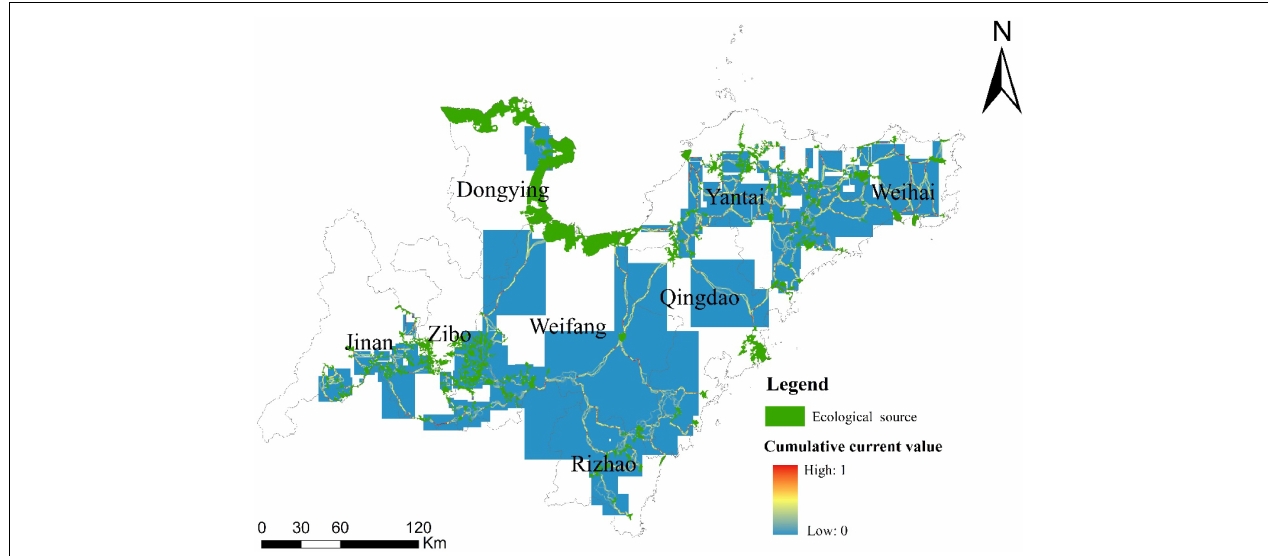
FIGURE 8 | Cumulative current value of ecological corridors in Shandong Peninsula urban agglomeration.